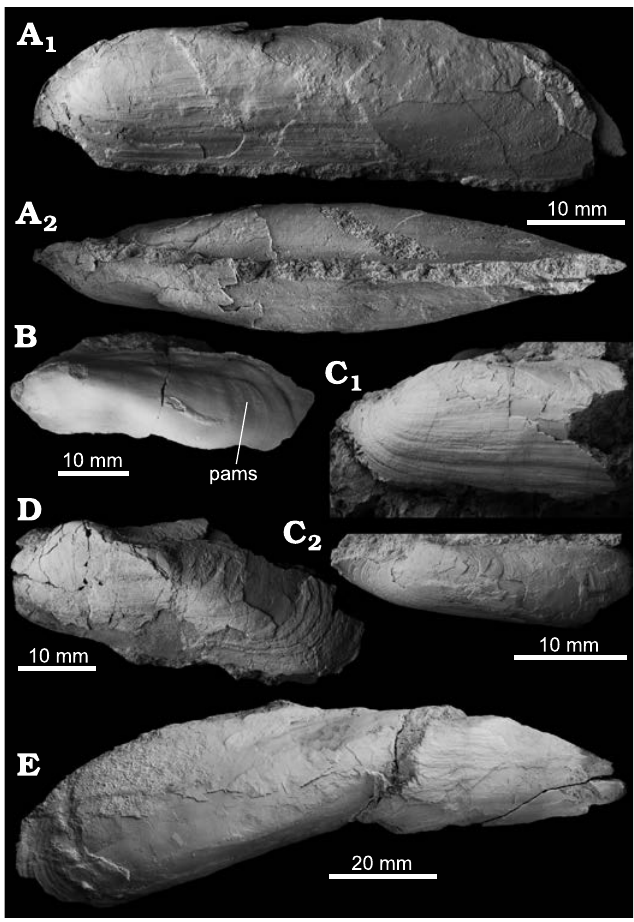
Fig. 4. The bathymodiolin bivalve Gigantidas coseli Saether, Little, Campbell, Marshall, Collins, and Alfaro, 2010, from Upper Miocene seep deposits of the Amlang Formation in Pangasinan province, Luzon, Philippines. A . NRM Mo 192455, articulated specimen, view on LV (A 1 ) and dorsal view (A 2 ). B . NRM Mo 192456, internal mold, view on LV showing posterior adductor muscle scar (pams). C . NRM Mo 192668, isolated LV, view on exterior (C 1 ) and on dorsal side (C 2 ). D . NRM Mo 192669, isolated LV, view on exterior. E . NRM Mo 192454, large, articu- lated, and slightly distorted specimen, view on